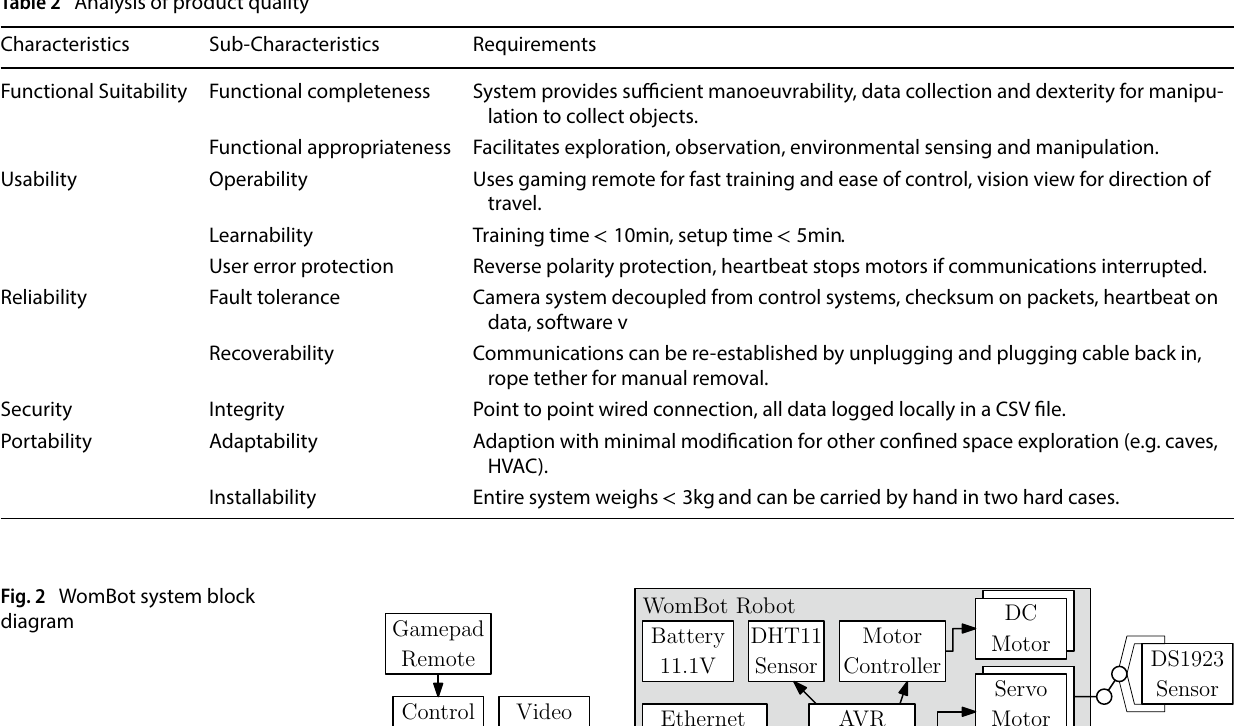
Table 2 Analysis of product quality Characteristics